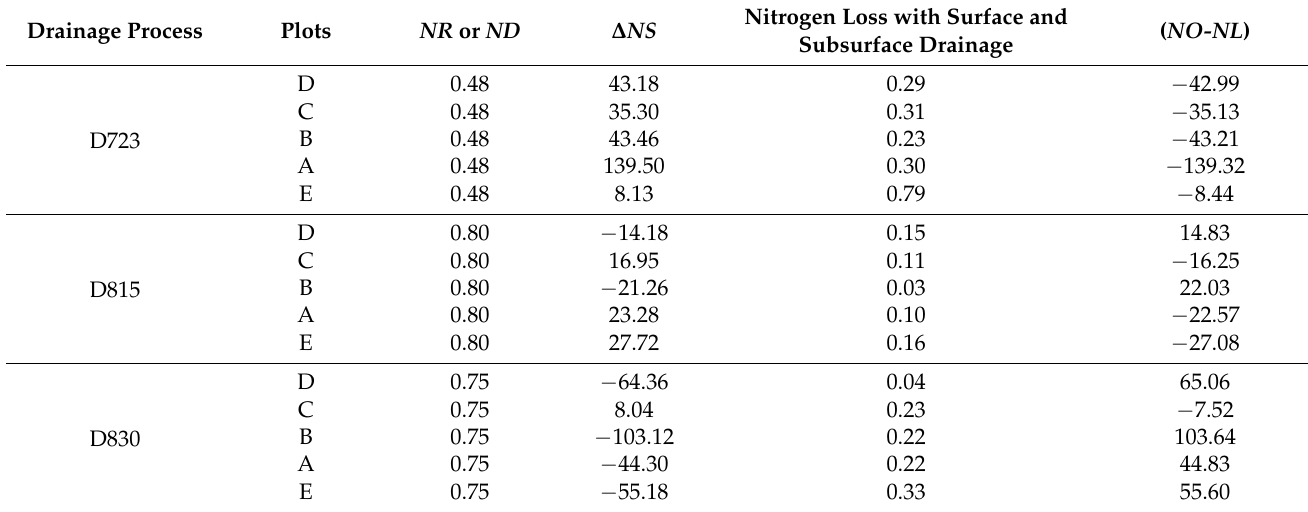
Table 7. Calculation of the nitrogen balance after three typical rainfalls (unit: kg/ha). Drainage Process